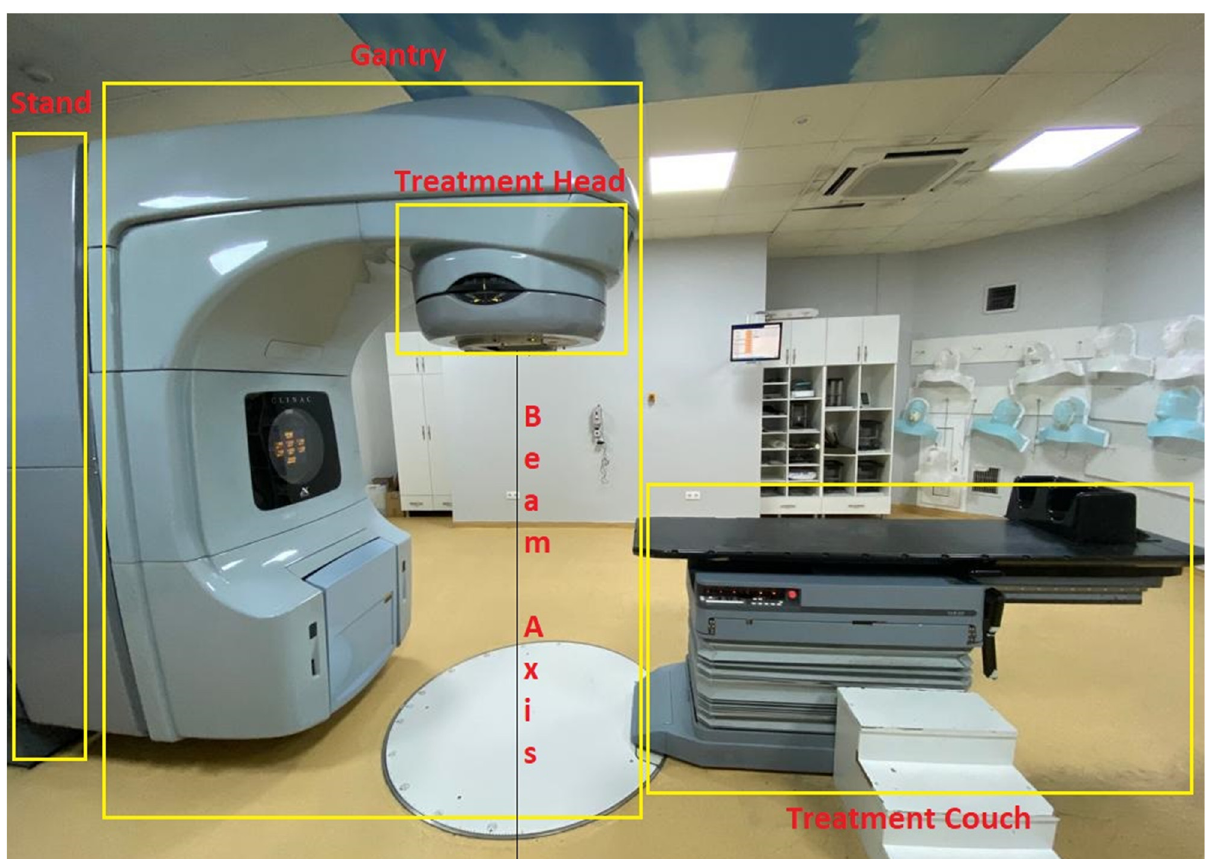
Figure 2: Treatment room and Varian Clinac IX – Radiation Oncology Department of Bulent Ecevit University Faculty of